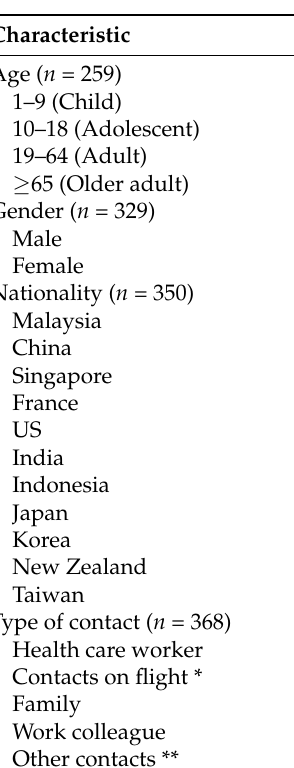
Table 3. Characteristics of close contacts of first wave COVID-19 cases in